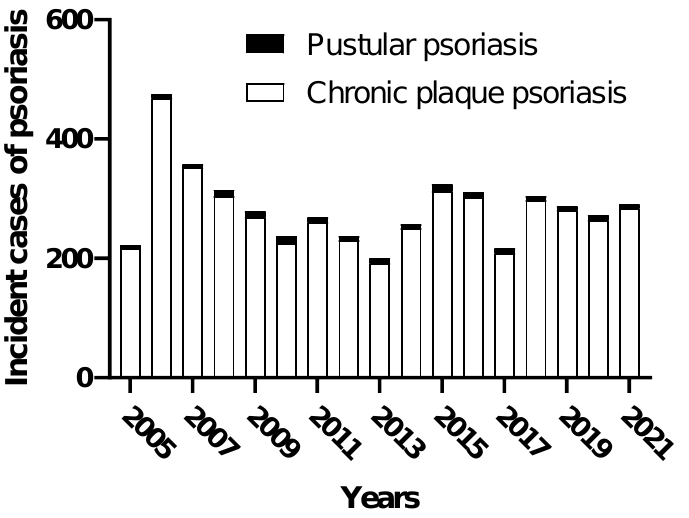
Figure 3. The number of incident cases of plaque versus pustular psoriasis diagnosed per year from 2005 to 2021. Plaque psoriasis (white histograms), pustular psoriasis (black histograms).